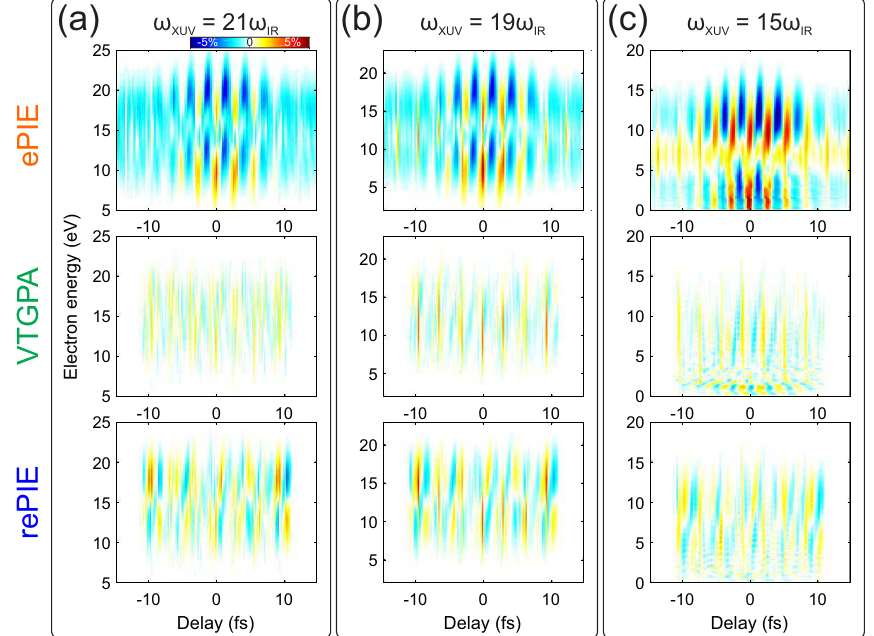
Figure 2. ( a – c ) Residual error for the reconstructed spectrograms which have as input the traces in Figure 1c,f,i, respectively. The first raw, extended Ptychograpic Iterative Engine (ePIE) outputs. Second and third rows, Volkov Transform Generalized Projection Algorithm (VTGPA) and refined extended Ptychograpic Iterative Engine (rePIE) results. In all cases, VTGPA and rePIE show considerably low reconstruction